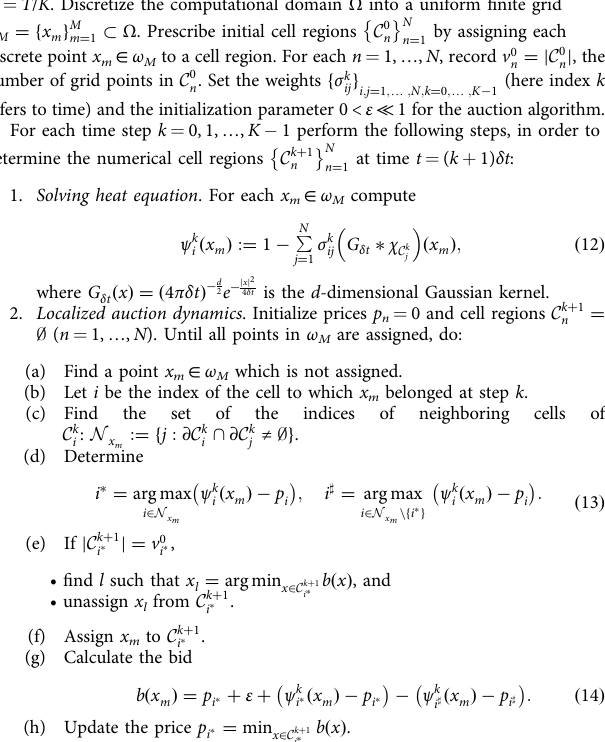
Algorithm 1 . (for numerical approximation of the L 2 -gradient fl ow of energy (Eq. 2) with preservation of cell volumes and connectivity) Notation: Denote by χ C . For given C the characteristic function of a set